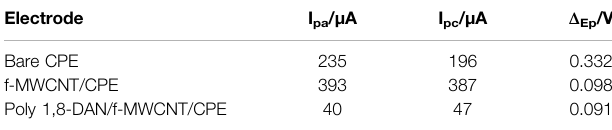
TABLE 1 | Comparison between I pa , I pc and the peak-to-peak separation ( Δ Ep ) for CPE, f-MWCNT/CPE and 1,8-DAN/f-MWCNT/CPE.